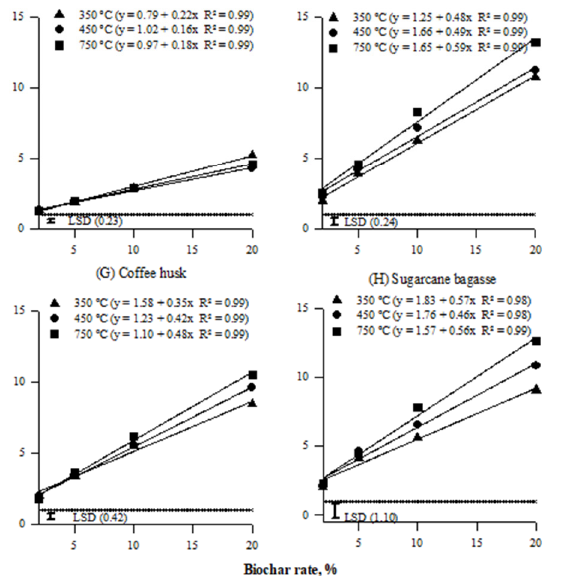
Figure 2. The total C of the Red Latosol (clayey texture) and Red ‐ Yellow Latosol as a function of biochar rates of chicken manure (A, E), eucalyptus sawdust (B, F), coffee husk (C, G) and sugarcane bagasse (D, H) pyrolyzed under different temperatures, after 9 months of incubation. Tukey’s LSD ( p <